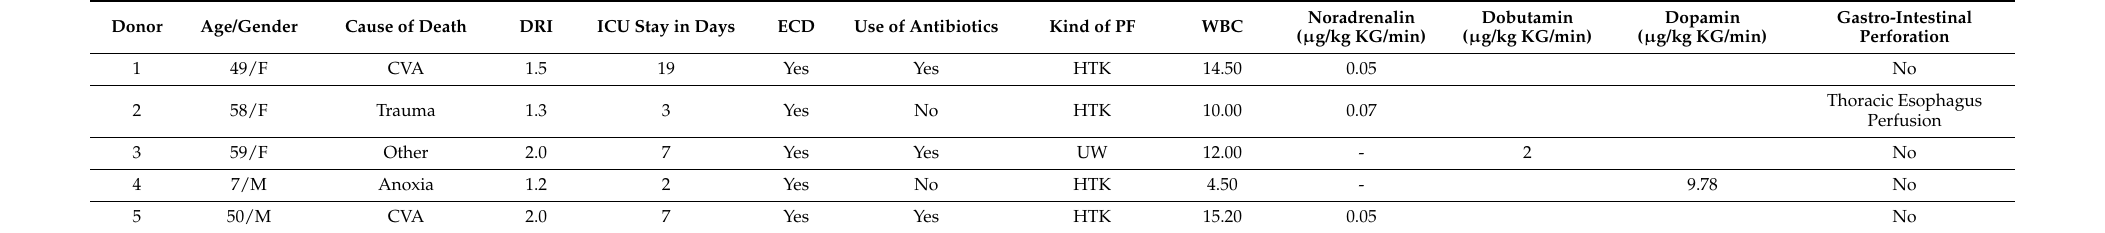
Table 2. Donor data of liver